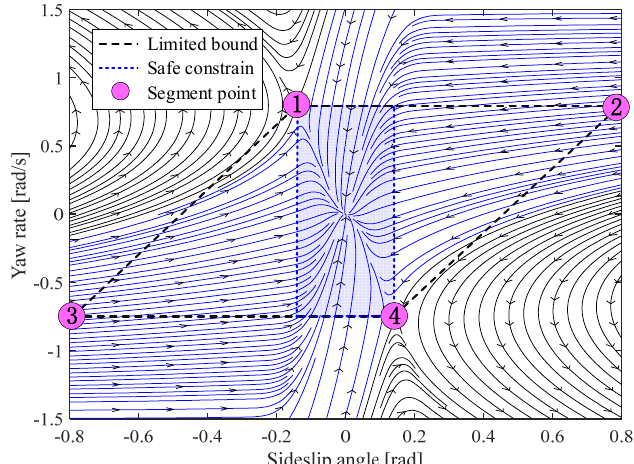
Figure 5. Limited bound and safe constrain. When setting the steering angle δ from − 0.35 to 0.35 rad, the trace of different fixed points at various steering angles can be described as the blue and red solid lines shown in Figure 4a,b, respectively, represent the trace of stable point and saddle point. The